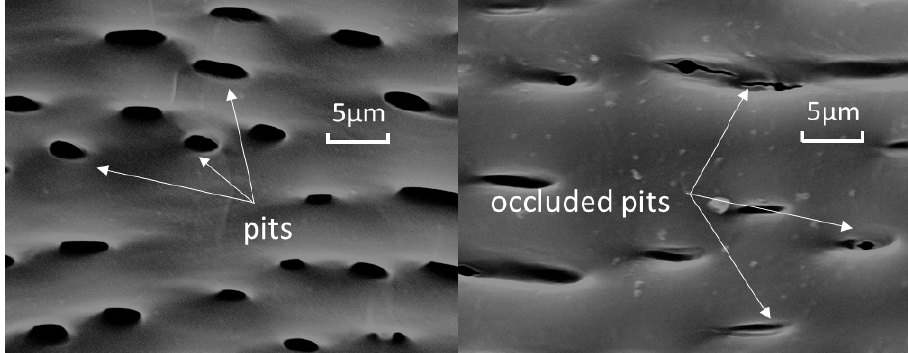
Figure 5. SEM micrographs of the control group (left) and the shellac treatment group (right).